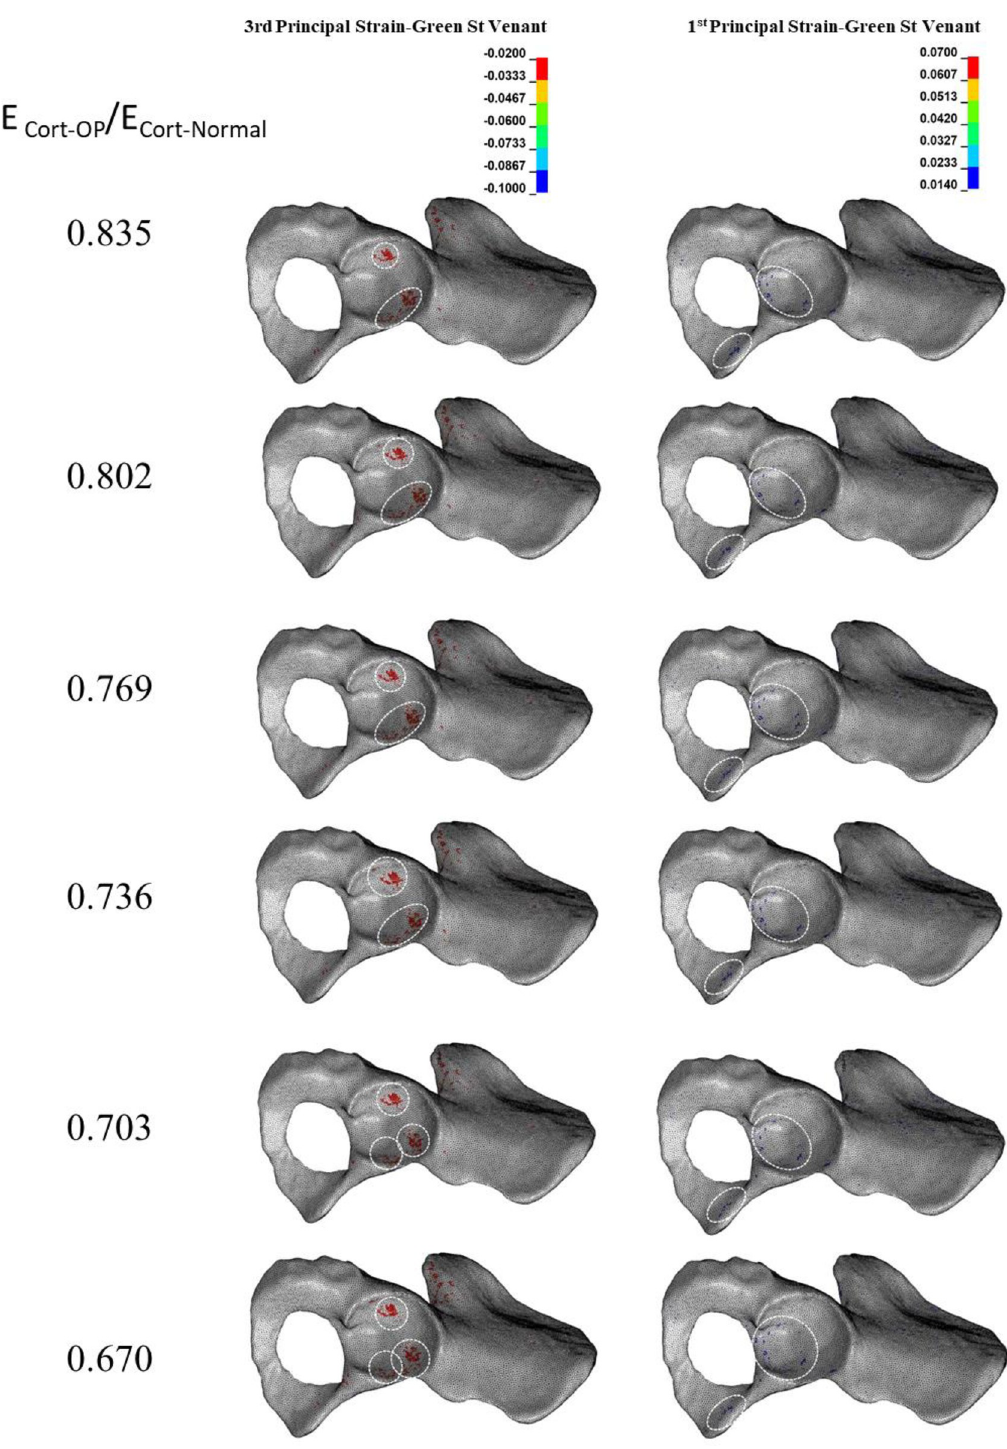
Fig 4. Effect of reduction in cortical elastic modulus due to osteoporosis (Ecort) on the compressive (left column) and tensile (right column) trabecular bone failure. Dashed circles: anatomical landmarks with a high risk of bone failure.